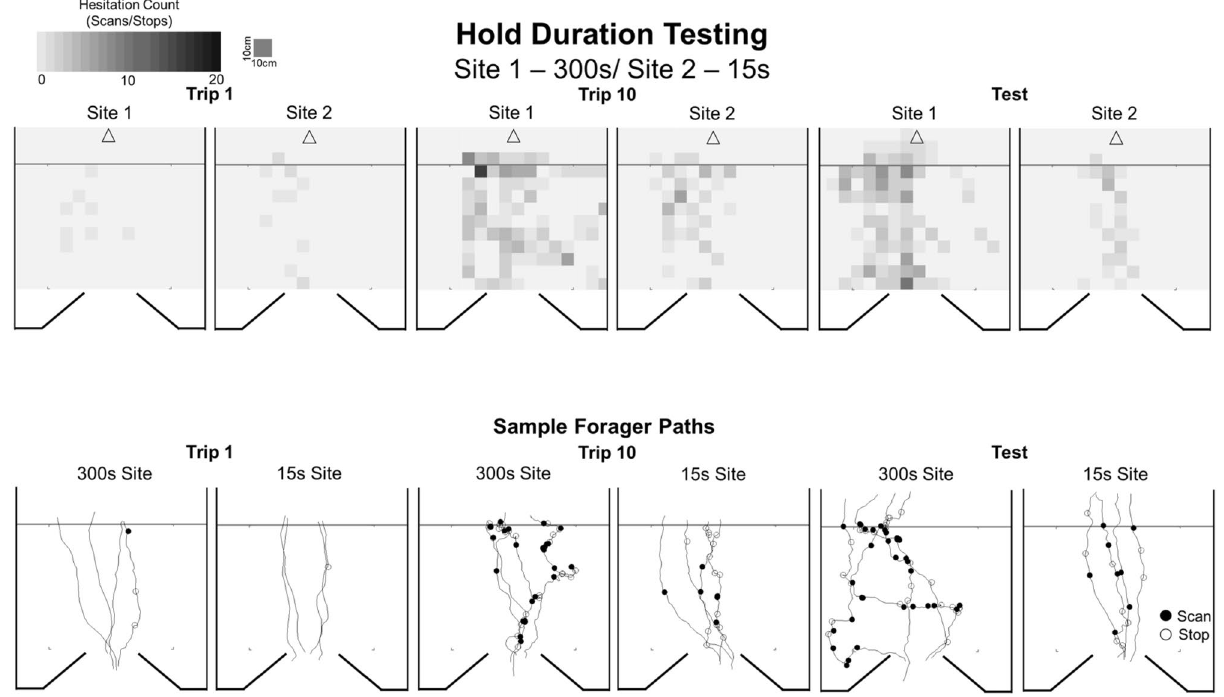
Figure 6. Heat maps of forager hesitation locations and sample paths in the Hold Duration testing. The nest direction is denoted by the arrow (top) for all panels and the black line crossing each heat map indicates the start of the collection area. Closed black circles denote locations of forager Scans while open circles denote Stop locations. For heat maps of hesitations for all training and test trips in the Hold Duration tests, see SFigs. 2 and